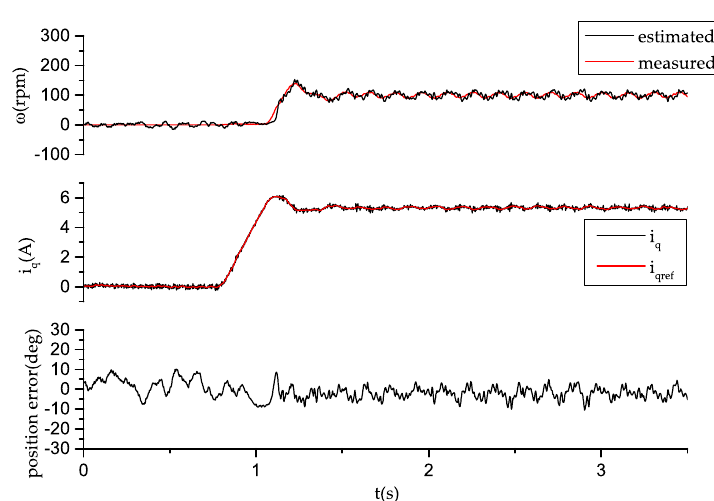
Figure 16. Experimental results of the start process, including the waveforms of actual and estimated speed, current i q and i q reference and position estimation error.